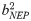
The noise equivalent power bNEP2 of magnetic fluctuations as a function of volume and magnetization relaxation time of an isotropic magnetite particle.The blue area shows the region where the particle can remain superparamagnetic at biological temperatures and provide the relative permeability k>300. The area to the right of the red line corresponds to the magnetic noise powers at which European robins were disoriented, according to Ref. [18].